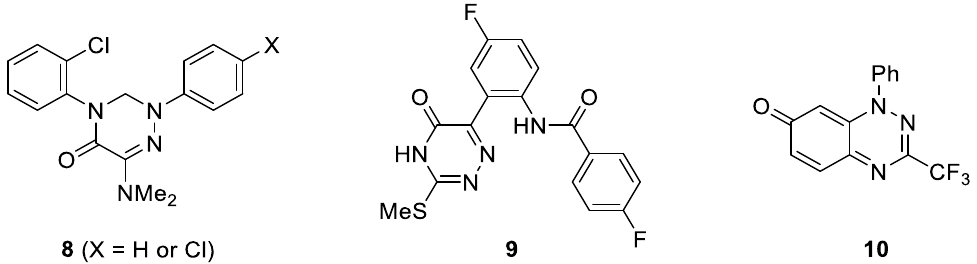
Figure 1. Structures of selected biologically active halogenated 1,2,4-triazinones.